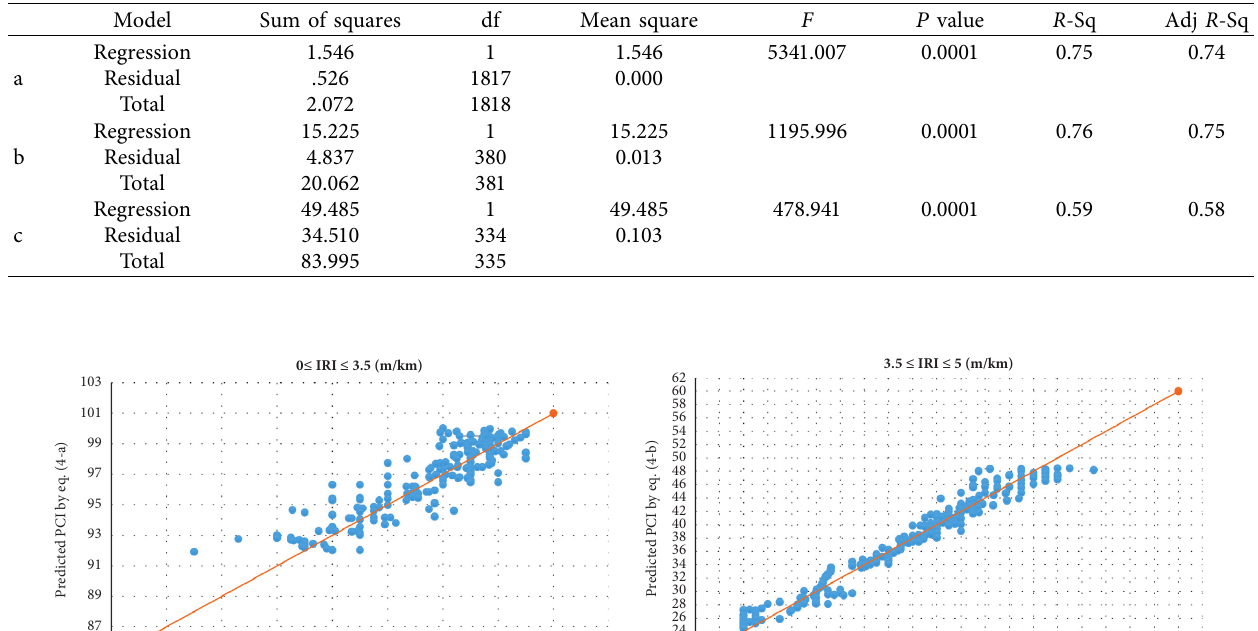
Table 3: ANOVA for regression and parameter estimates with one predictor